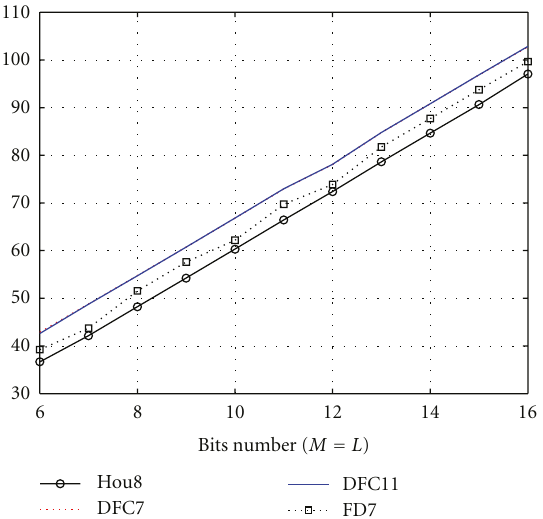
Figure 12: Peak-signal-to-noise ratio (PSNR).